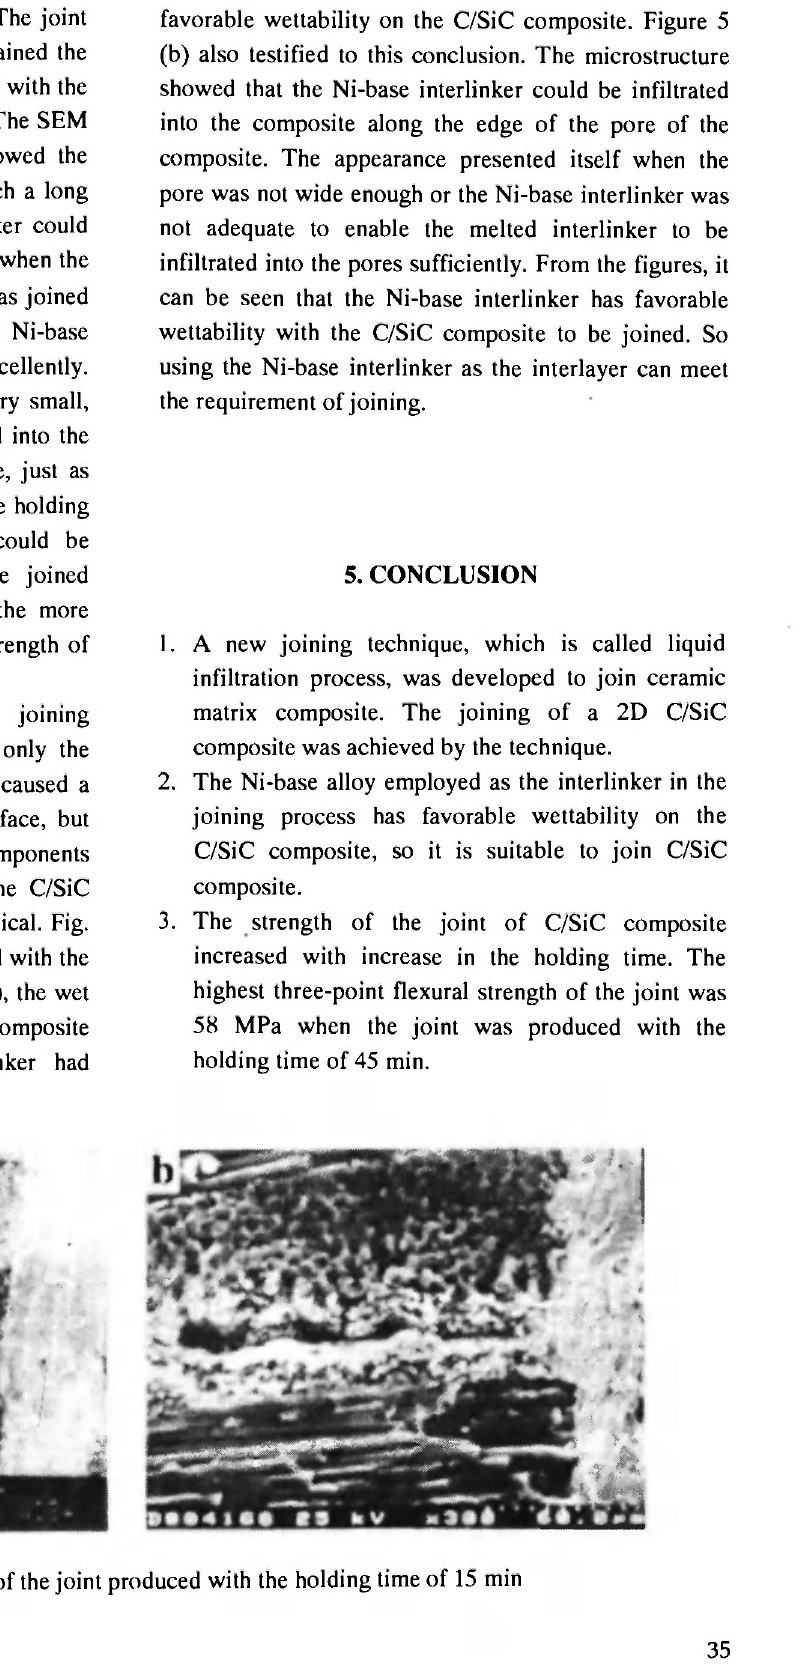
Fig. 5: SEM fractographs of the joint produced with the holding time of 15